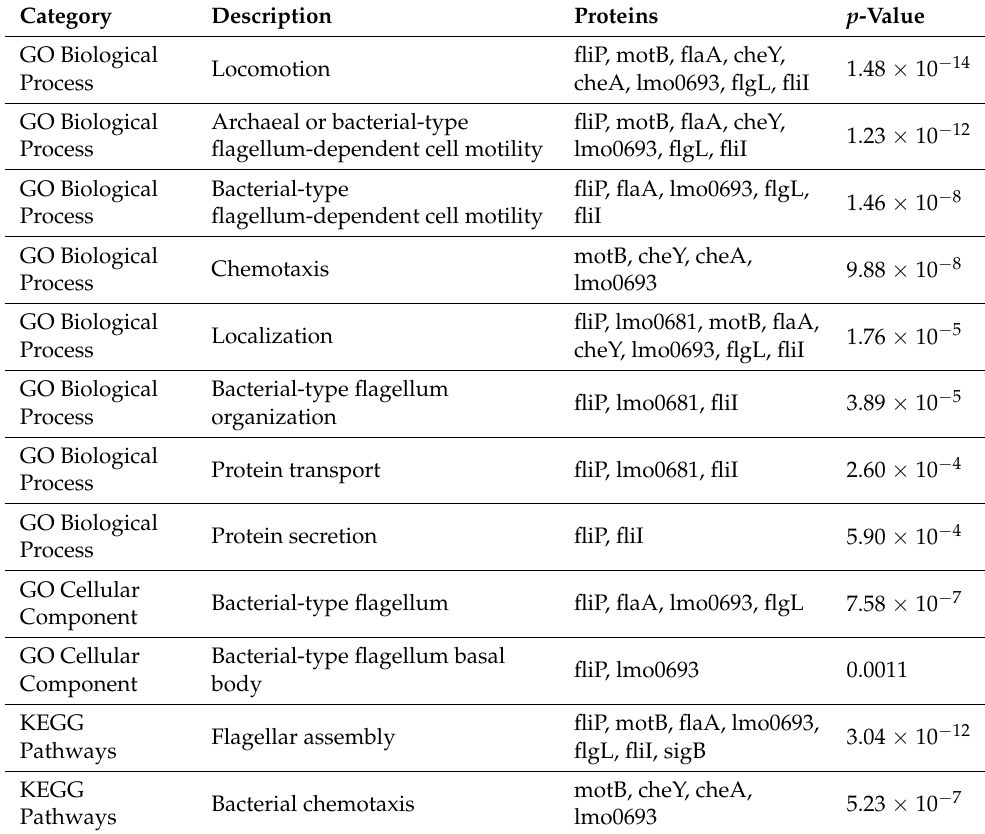
Table A4. STRING functional enrichment analysis for top 10 nodes for